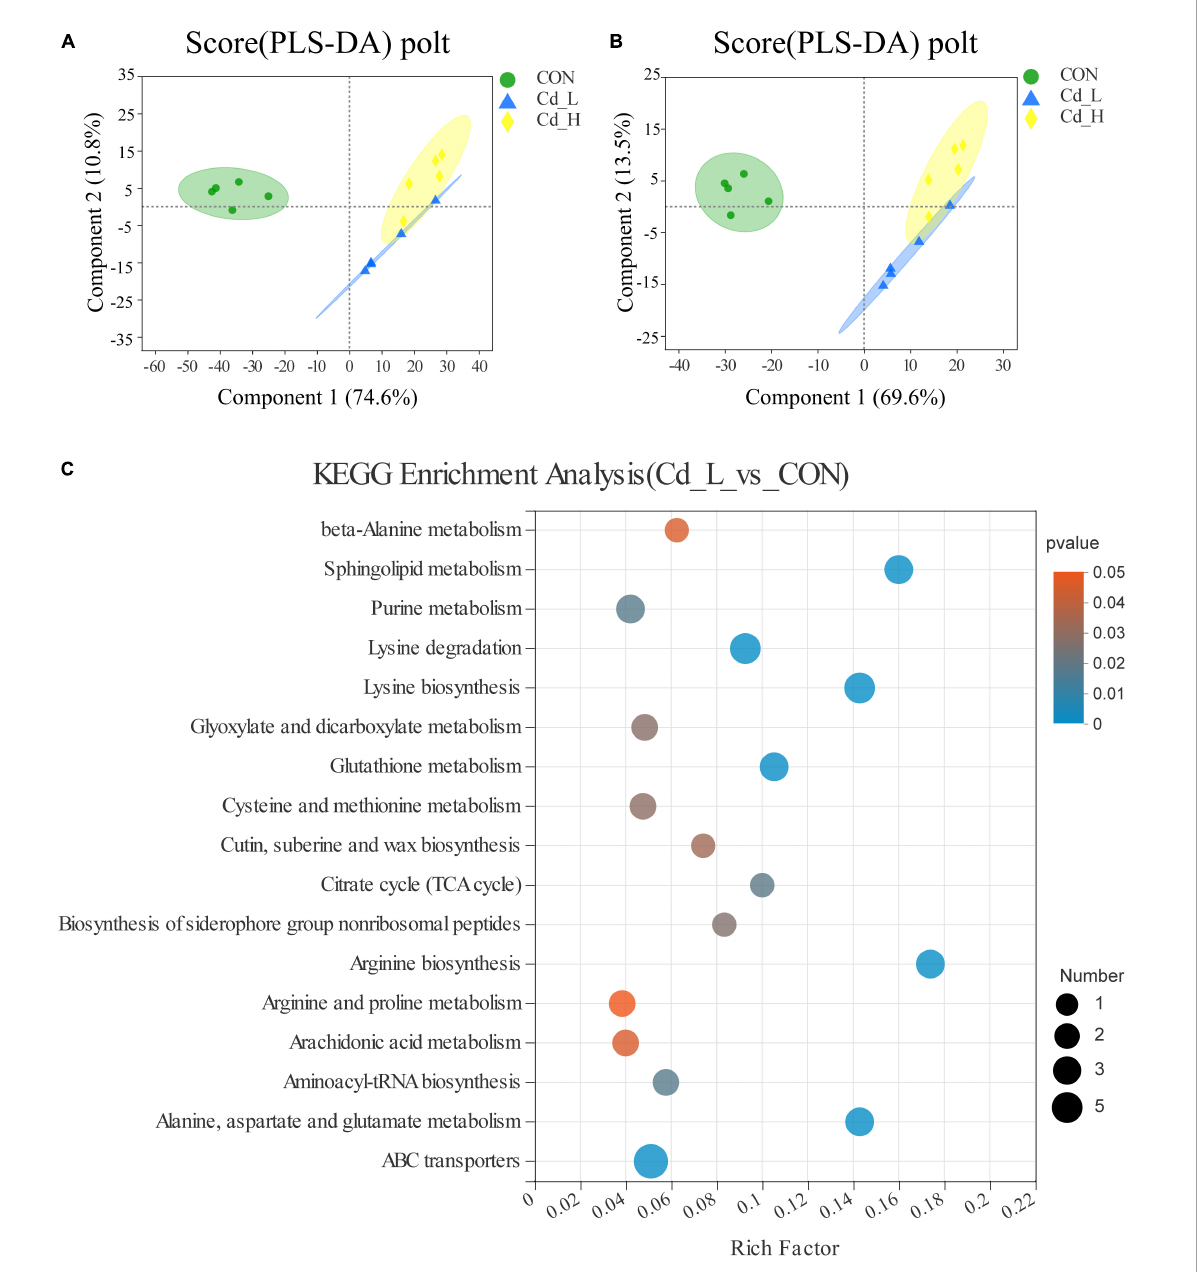
FIGURE5 Effects of Cd stress on T. pubescens metabonomic profiling by UHPLC-Q Exactive MS. (A,B) PLS-DA score plot of three groups (Cd_L, Cd_H, CON) in the positive ion and negative ion. (C) KEGG enrichment analysis between Cd_L and CON groups. Cd, cadmium; Cd_L, low-dose Cd treatment group; Cd_H, high-dose Cd treatment group; CON, no Cd treatment group; UHPLC, ultra-high-performance liquid chromatography; PLS-DA, partial least squares discriminant analysis; KEGG, Kyoto Encyclopedia of Genes and